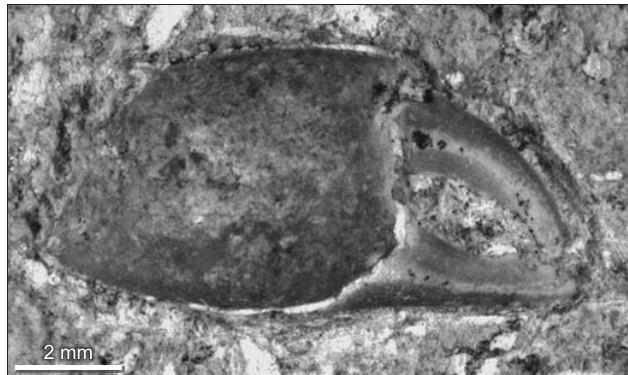
Fig. 5. Brachyura indet. (right cheliped) from the upper Aptian–lower Albian Romualdo Formation of the Santana Group, Araripe Basin, Per- nambuco. DGEO-CTG-UFPE-7743, possibly akin to Araripecarcinus fer- reirai Martins-Neto,